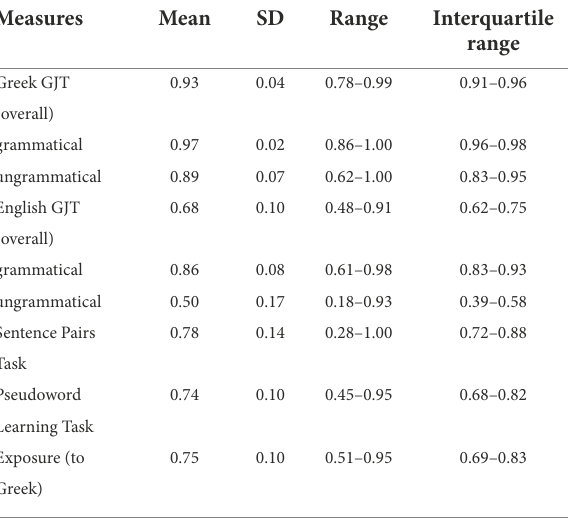
TABLE 3 Proportions of correct responses, SDs, ranges and IQR for all